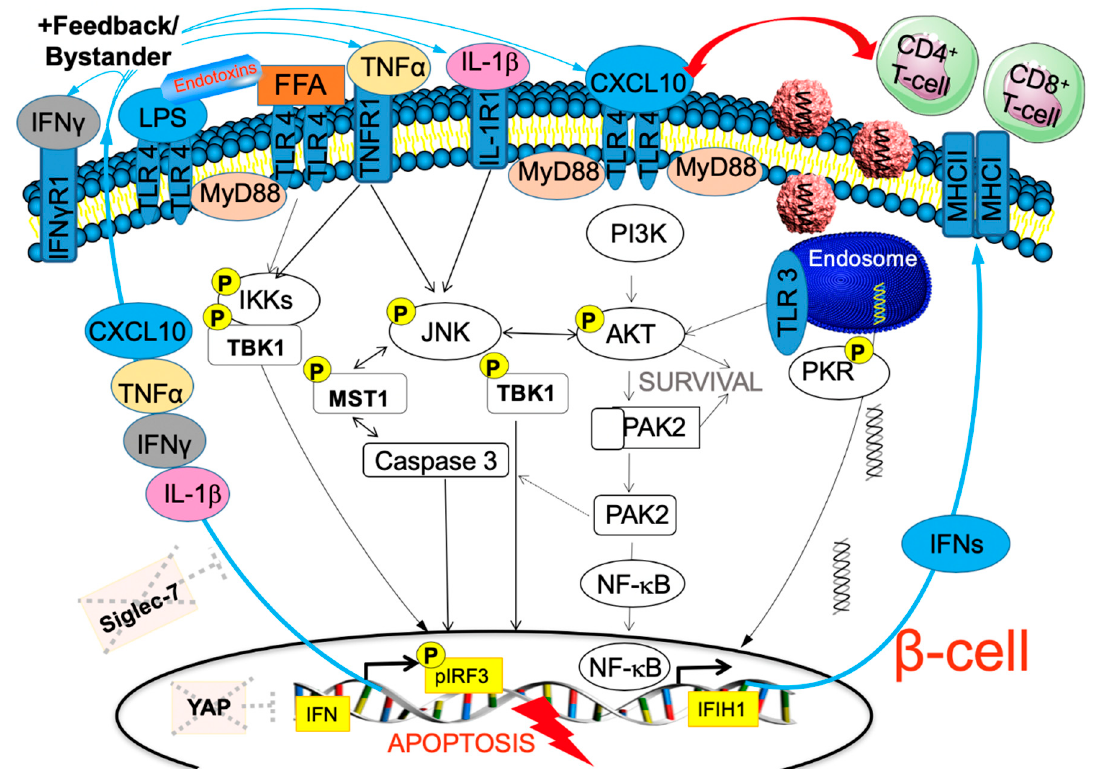
Figure 4. β -cell in the storm. Our hypothetical model on how chronic potentiation of proinflammatory pathways leads to β -cell destruction. Coxsackieviruses enter the β -cell through the Coxsackie– adenovirus receptor (CAR) and bind to endosomal TLR3. While the virus promotes the AKT-JNK axis for initial host cell survival, parallel activation of viral response pathways through PKR-TBK-IRF3 leads to the transcriptional activation of the IFN response and production of interferons, which increase surface MHCs, recognized by cytotoxic CD8- and CD4-T-cells causing “bystander damage”, and β -cell apoptosis through a “storm” of cytokines and chemokines, which all find their receptors on the surface of the β -cell, and a vicious cycle is initiated with the full activation of the apoptotic machinery including JNK-MST1-Caspase 3-NF κ B. Bacterial toxins as well as chronically elevated free fatty acids (FFA) are also associated with β -cell damage and act through TLR4 activation and similar